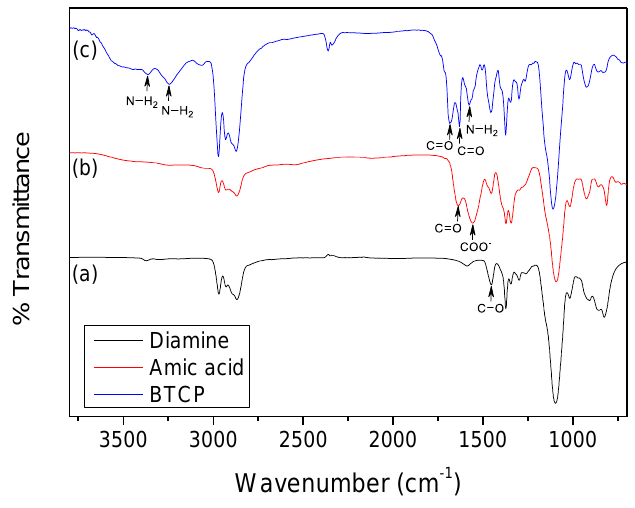
Figure 5. FT-IR spectra of ( a ) diamine, ( b ) amic acid and ( c ) BTCP.